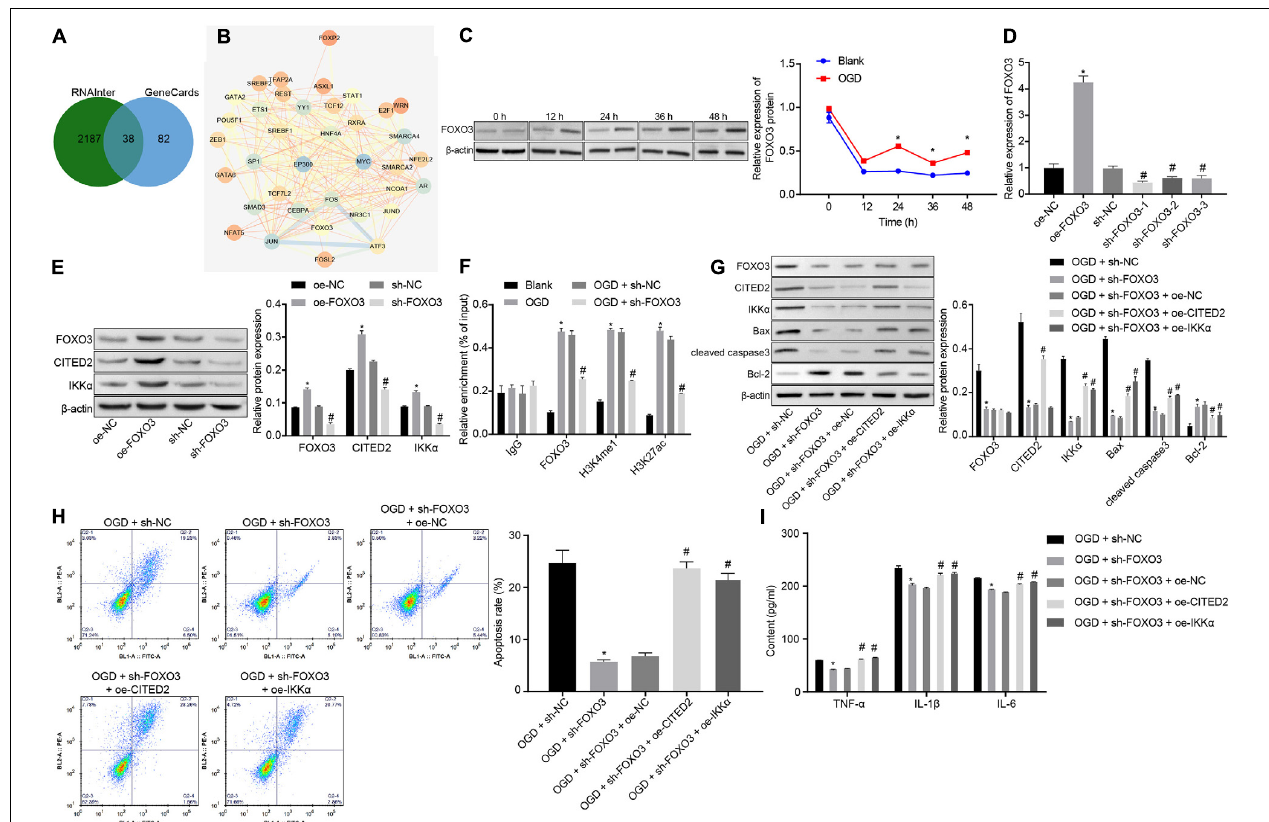
FIGURE 4 | FOXO3 upregulates CITED2 and IKK α expressions to enhance OGD-induced neuronal cell apoptosis. (A) Venn plot of the intersection of CITED2-related transcription factors and brain ischemia injury-related genes in GeneCards predicted on the RNAInter website. (B) The network diagram of interaction relationships among 38 genes analyzed on the STRING website, with the color of circles from blue to orange indicating degree and the line in the middle of circles referring to the co-expression relationship between genes. (C) The protein expression of FOXO3 normalized to β -actin at different time points after OGD treatment determined by western blot analysis. (D) The mRNA expression of FOXO3 in neuronal cells determined by RT-qPCR after overexpression or knockdown of FOXO3. (E) The protein expressions of FOXO3, CITED2, and IKK α normalized to β -actin after overexpression or knockdown of FOXO3 measured by western blot analysis. (F) The enrichment of FOXO3, H3K4me1, and H3K27ac in the enhancer region of CITED2 detected by ChIP assay in neurons. (G) Western blot analysis for the determination of the expression of apoptosis-related proteins (cleaved caspase 3, Bax, Bcl-2, and caspase 3 expression) normalized to β -actin in neurons. (H) The apoptosis of neurons in each group examined by flow cytometry. (I) Expression of inflammatory cytokine (TNF- α , IL-1 β , and IL-6) in the cell supernatant determined by ELISA. In panel (C) , * p < 0.05 vs. the blank group (neuronal cells without OGD treatment). In panels (D,E) , * p < 0.05 vs. neuronal cells treated with oe-NC; # p < 0.05 vs. neuronal cells treated with sh-NC. In panel (F) , * p < 0.05 vs. neuronal cells treated with IgG; # p < 0.05 vs. neuronal cells treated with the blank group (neuronal cells without OGD treatment); In panels (G – I) , * p < 0.05 vs. OGD-exposed neuronal cells treated with sh-NC; # p < 0.05 vs. OGD-exposed neuronal cells treated with sh-FOXO3 and oe-NC. Measurement data were expressed as mean ± standard deviation. Unpaired data in compliance with normal distribution and homogeneity between two groups were compared using an unpaired t -test. Comparisons among multiple groups were conducted by one-way ANOVA with Tukey’s post hoc test. Data at different time points were compared by repeated-measures ANOVA, followed by Bonferroni’s post hoc test. The experiment was repeated three times